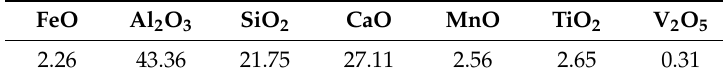
Table 6. Major element compositions of alumina